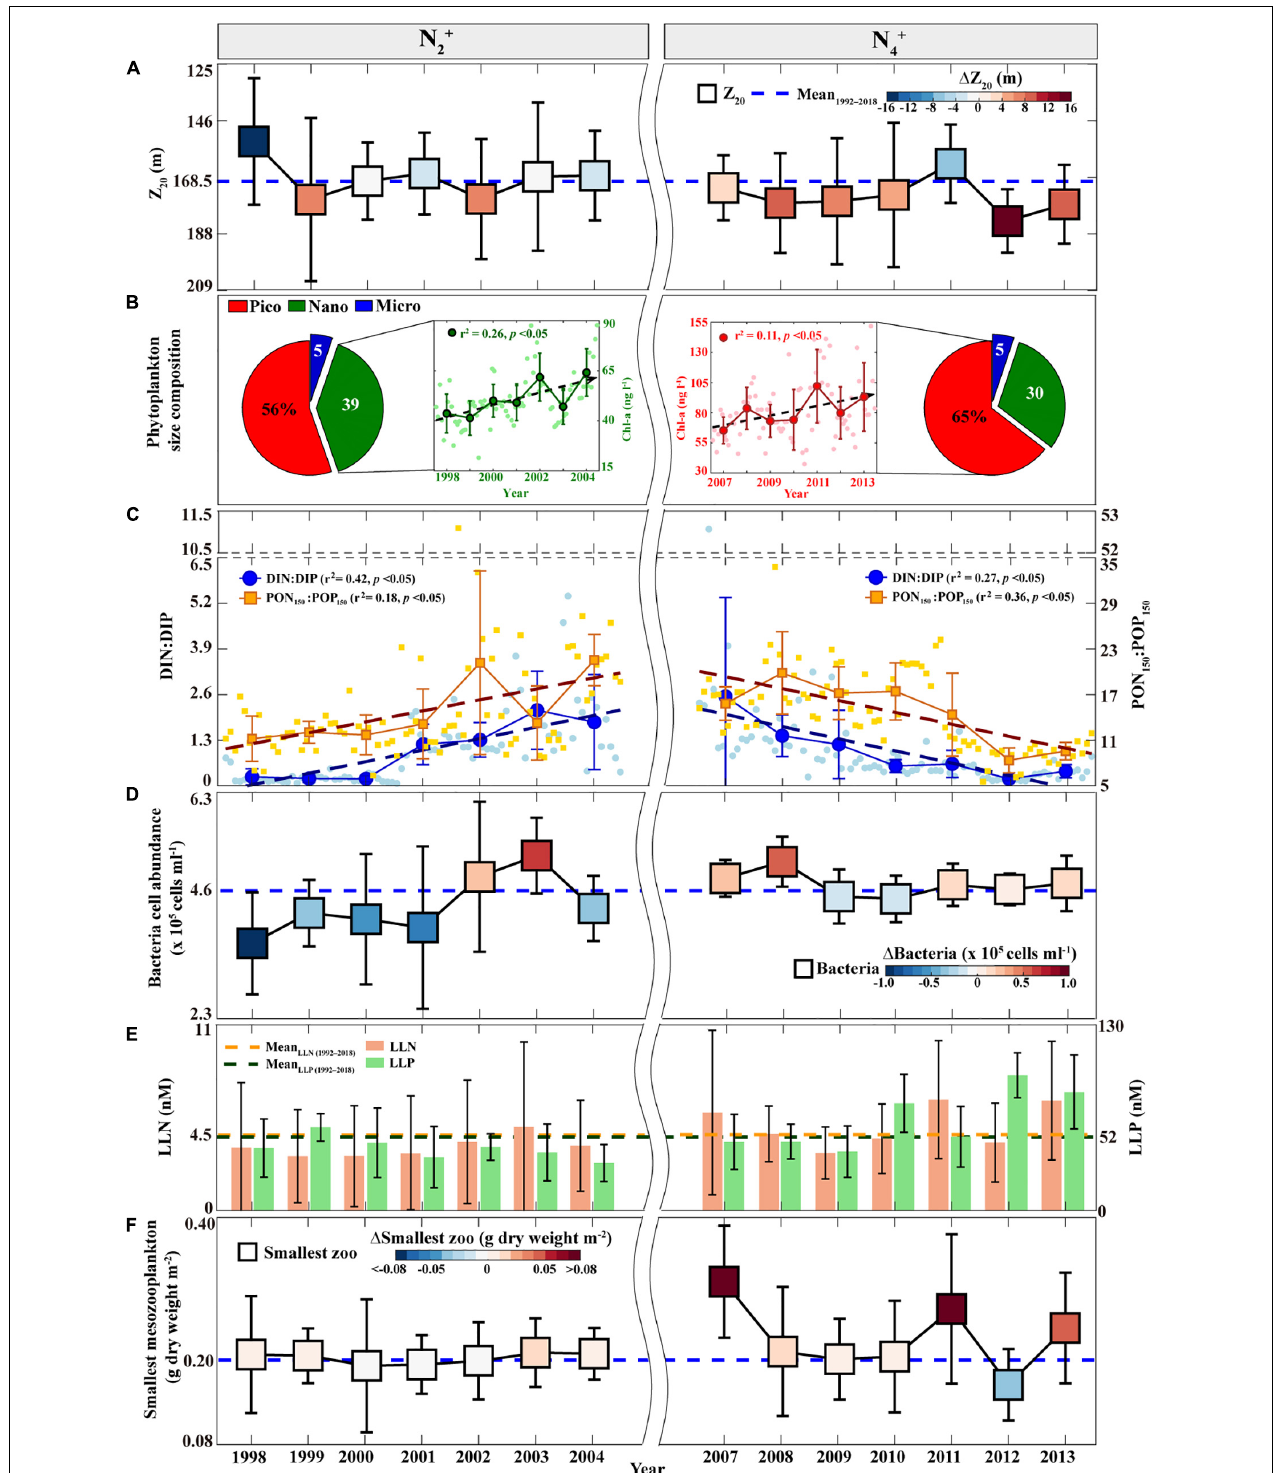
FIGURE 3 | Annual time series of the environmental parameters measured at Station ALOHA during the N 2 + and N 4 + phases: (A) Z 20 , in which error bars indicate the STDs, dotted blue line indicates the average during the study period, and color bar indicates (cid:49) Z 20 (the annual average minus the average during the study period); (B) Pigment-based phytoplankton-sized fractions averaged during each phase and phytoplankton Chl-a biomass (larger circles; nano-sized phytoplankton during the N 2 + phase and pico-sized phytoplankton during the N 4 + phase), in which error bars indicate the STDs, dotted lines indicate increasing linear trends,